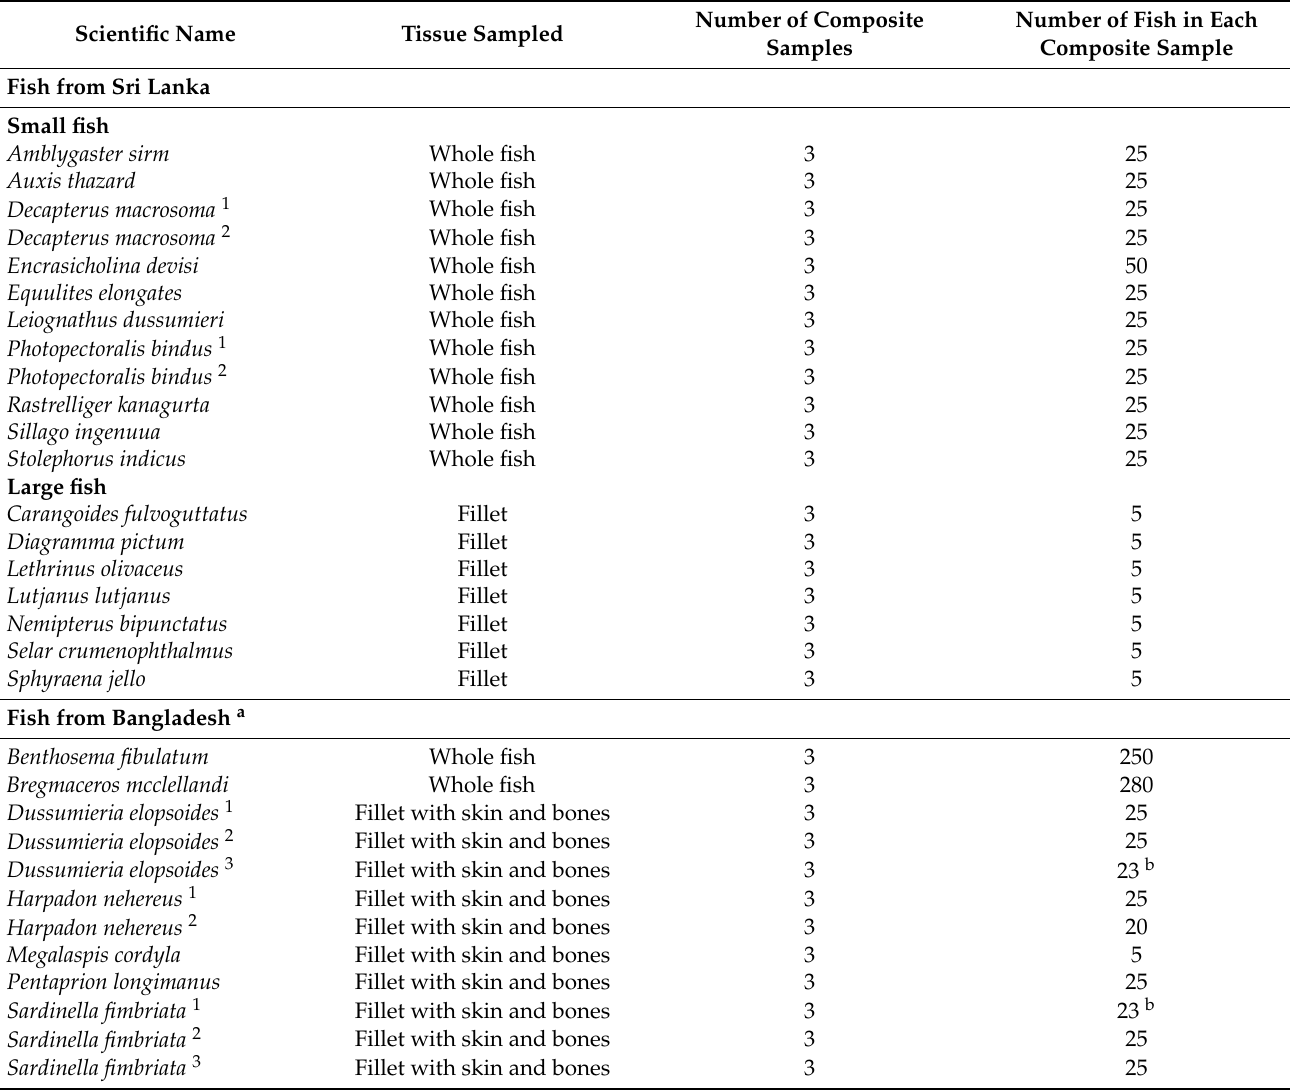
Table 2. Overview of species sampled, tissue, number of composite samples, and number of fish in each composite